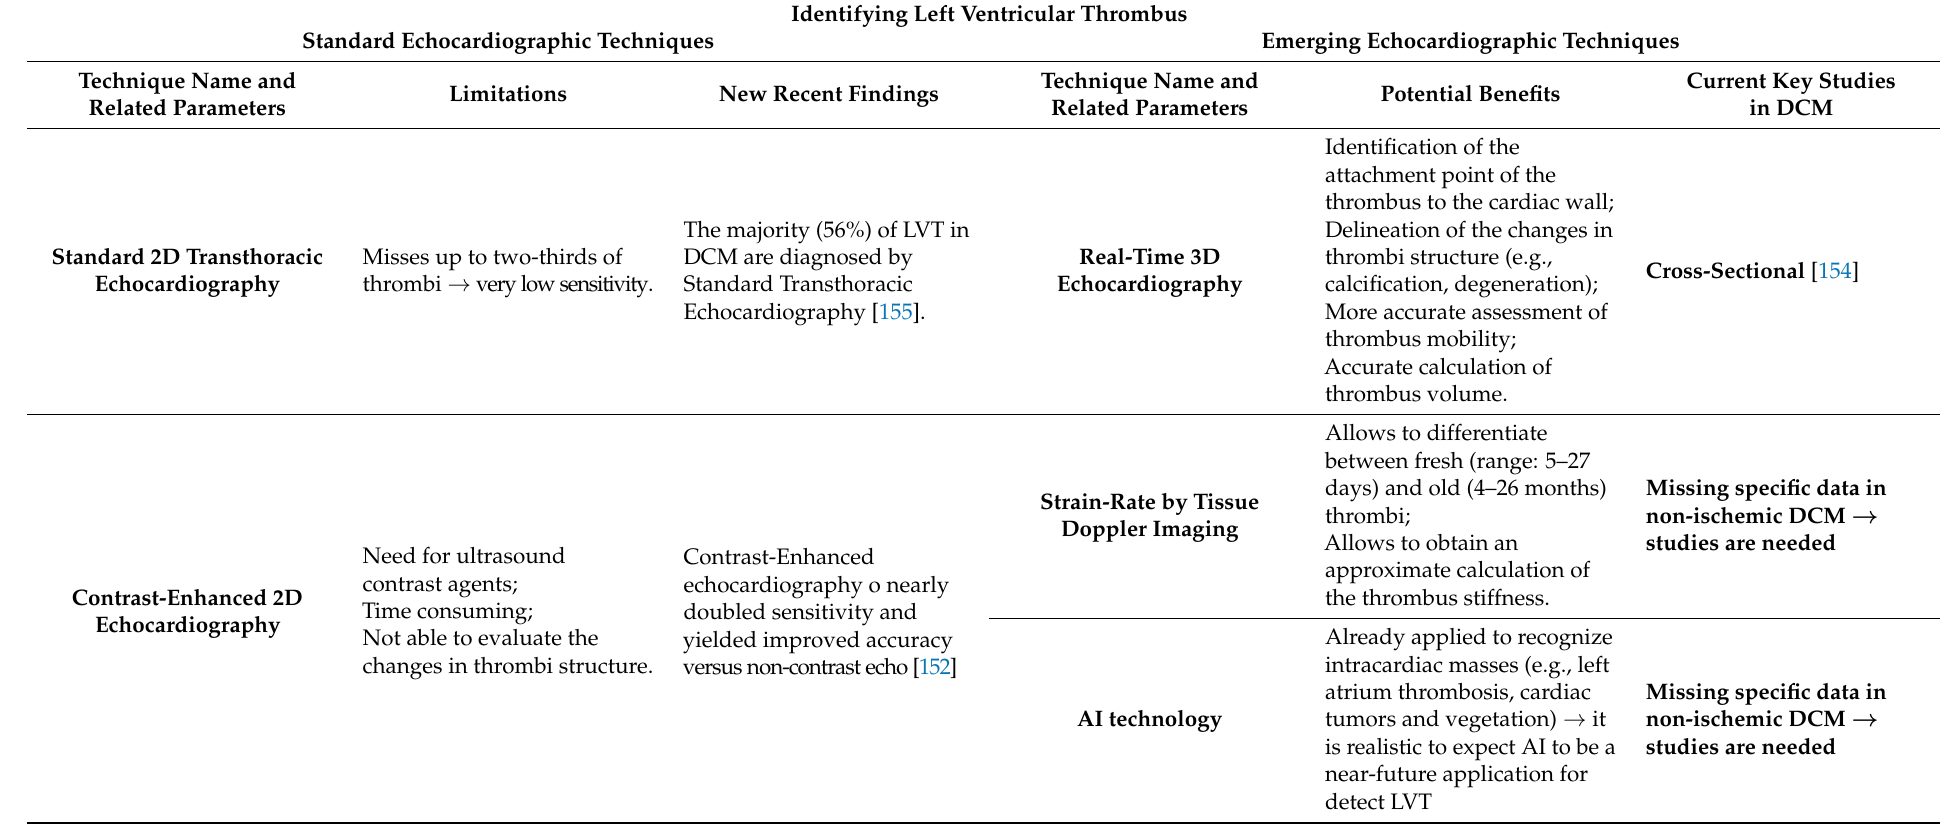
Table 6. Comparison between Standard and Emerging echocardiographic techniques to identify left ventricular thrombus in dilated